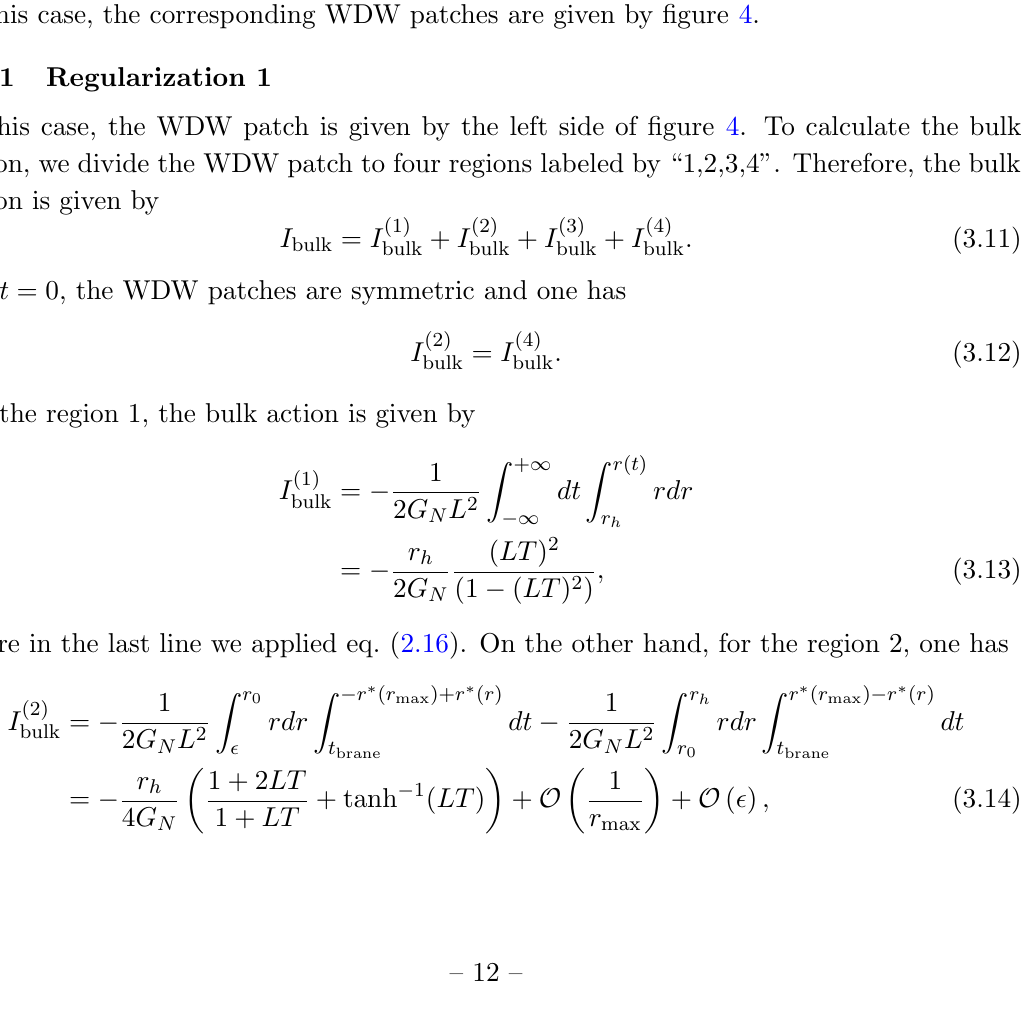
Figure 4 . WDW patches indicated in cyan for T > 0 and r ization and right) second regularization. There are two cuto(cid:11) surfaces, one at r = (cid:15) and the other one at r = r max which is the UV